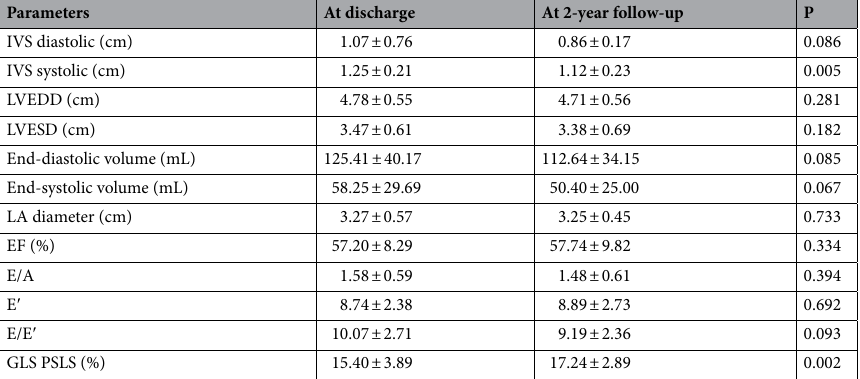
Table 1. Comparison of standard echocardiographic and strain analysis parameters between at discharge and at 2-year follow-up. IVS interventricular septum, LVEDD end-diastolic dimensions, LVESD